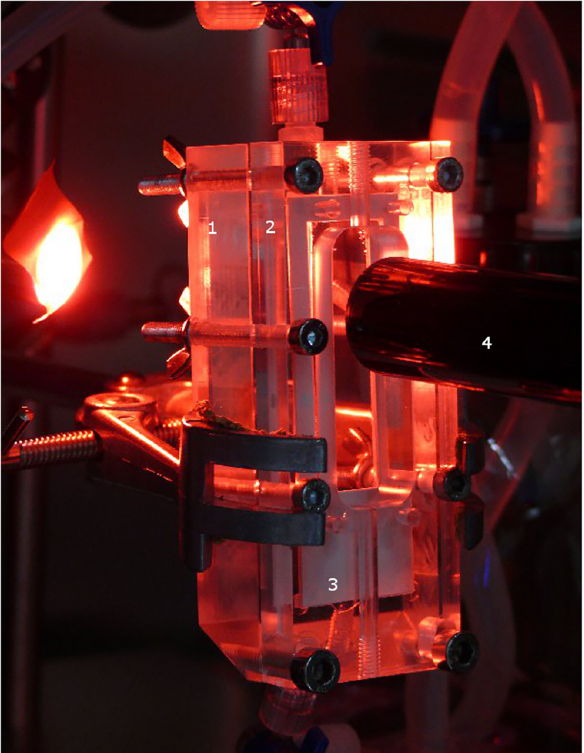
Fig 1. The ENDOXY system set up as a bioreactor for application of defined shear stress on endothelial cells. 1 – gas chamber, 2 – medium / blood chamber, 3 – Lumox ™ slide, 4 – microscope.